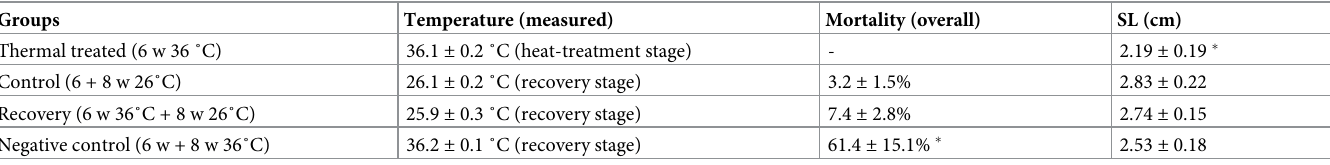
Table 2. Effects of thermal treatments on the body lengths and mortality in experiment 2.